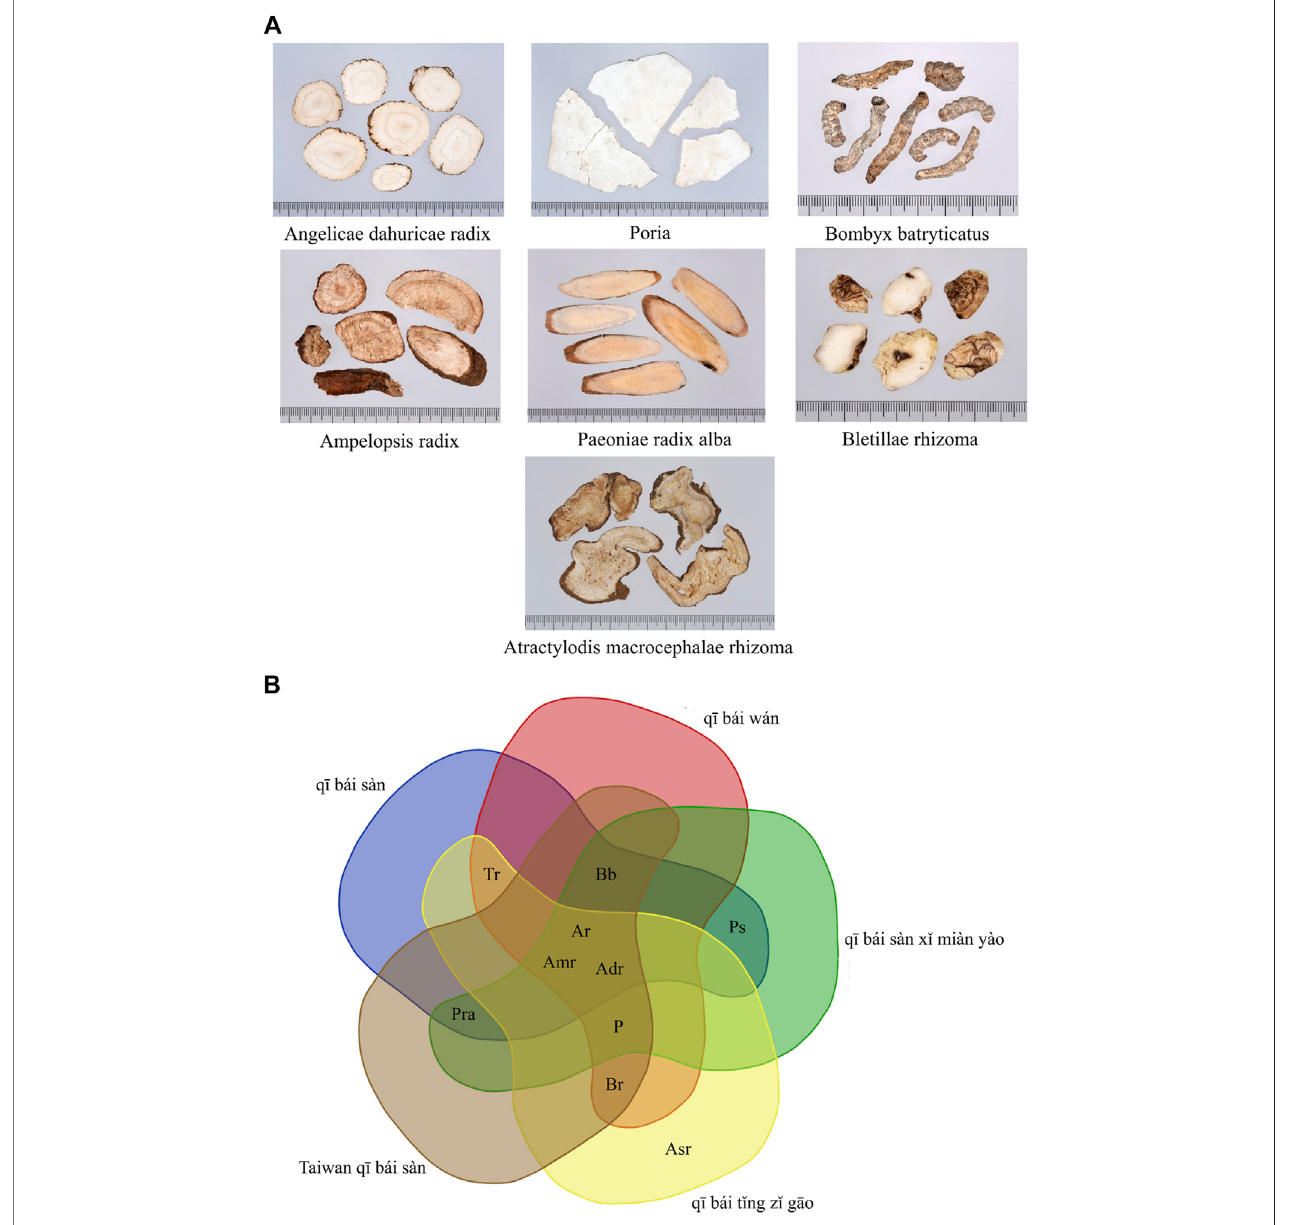
FIGURE8|(A) PicturesofmedicinalmaterialsofTaiwan q ī báisàn . (B) Venndiagramof q ī báisàn -relatedprescriptionsinancientbooksandTaiwan q ī báisàn .Adr, Angelica dahurica (Hoffm.) Benth. & Hook. f. ex Franch. & Sav.; Amr, Atractylodes macrocephala Koidz.; Ar, Ampelopsis japonica (Thunb.) Makino; Asr, Asarum heterotropoides F. Schmidt f. mandshuricum (Maxim.) Kitag.; Bb, Bombyx mori Linnaeus; Br, Bletilla striata (Thunb.) Rchb. f.; P, Wol fi poria extensa (Peck) Ginns; Pra, Paeonia lacti fl ora Pall. (white); Ps, Ipomoea nil (L.). Roth; Tr, Sauromatum giganteum (Engl.) Cusimano &